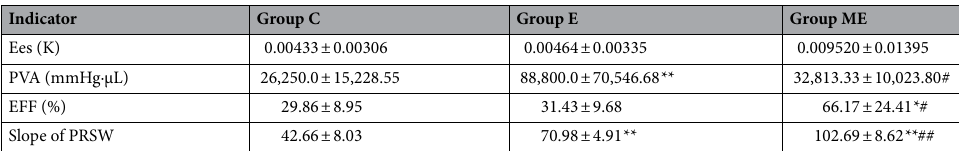
Table 3. Changes in hemodynamics after obstructing blood flow in the inferior vena cava. * p < 0.05, ** p < 0.01, compared to group C. # p < 0.05, ## p < 0.01, compared to group E. (C = Control, E = Exercise training, ME = Exercise training combined with MOTS-c treatment. Ees = ventricular end-systolic elasticity, PVA = pressure volume area, EFF = mechanical efficiency, the slope of PRSW = K(SW − EDV)).